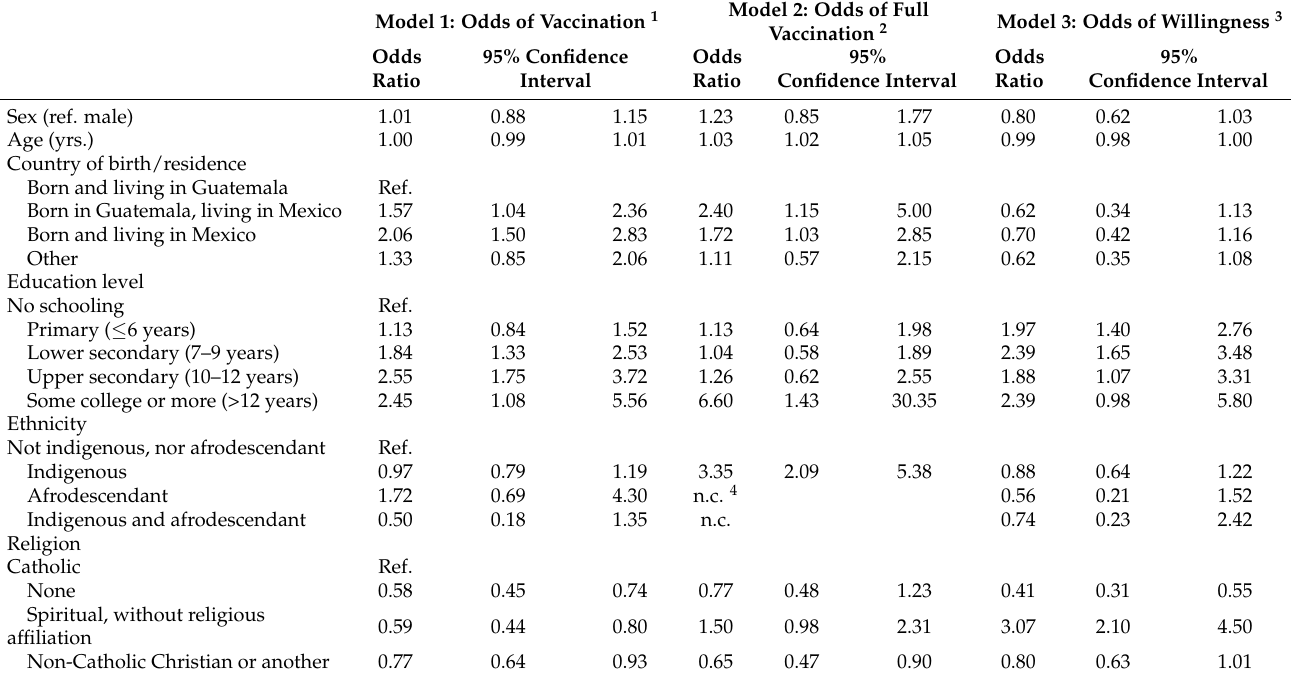
Table 4. Factors associated with vaccination and willingness to be